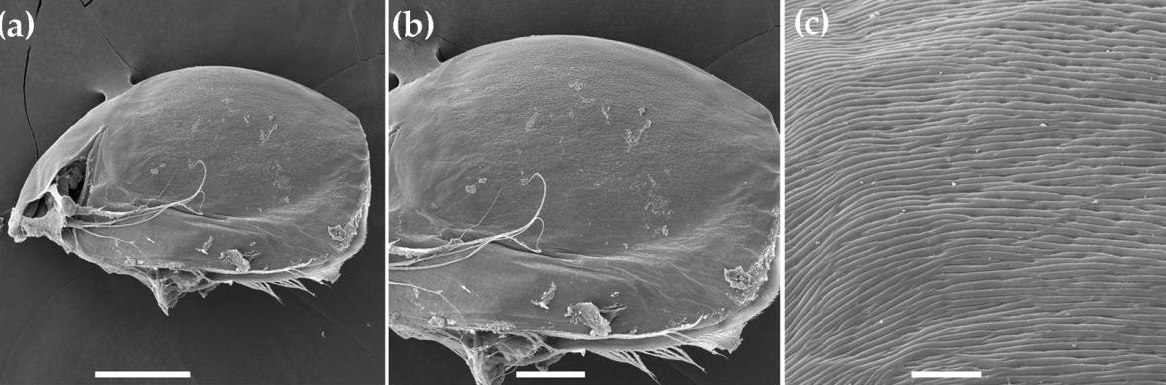
Figure 15. Anthalona mediterranea , an ephippial female from Wadi Maidaq — Blue Pool, United Arab Emirates: ( a ) female, lateral view; ( b ) ephippium; ( c ) ephippium with higher magnification. Scale bars: 0.1 mm for ( a ), 0.05 mm for ( b ), 0.01 mm for ( c ).